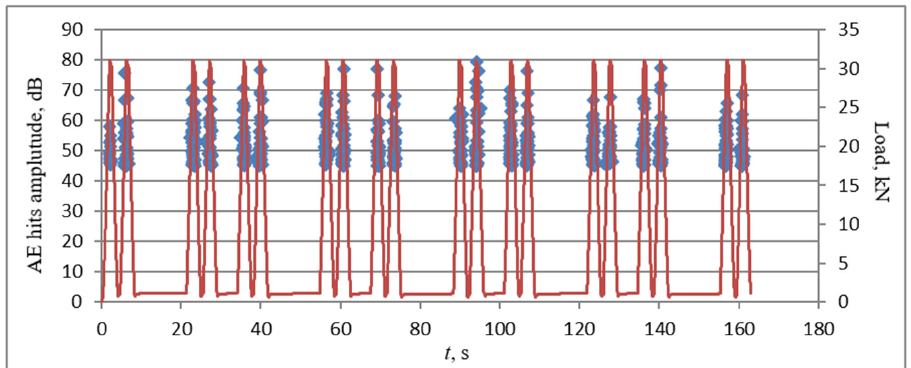
Figure 8. Dependence of AE hits amplitudes on time (blue) and dependence of loading force on time (red) for defective specimen.